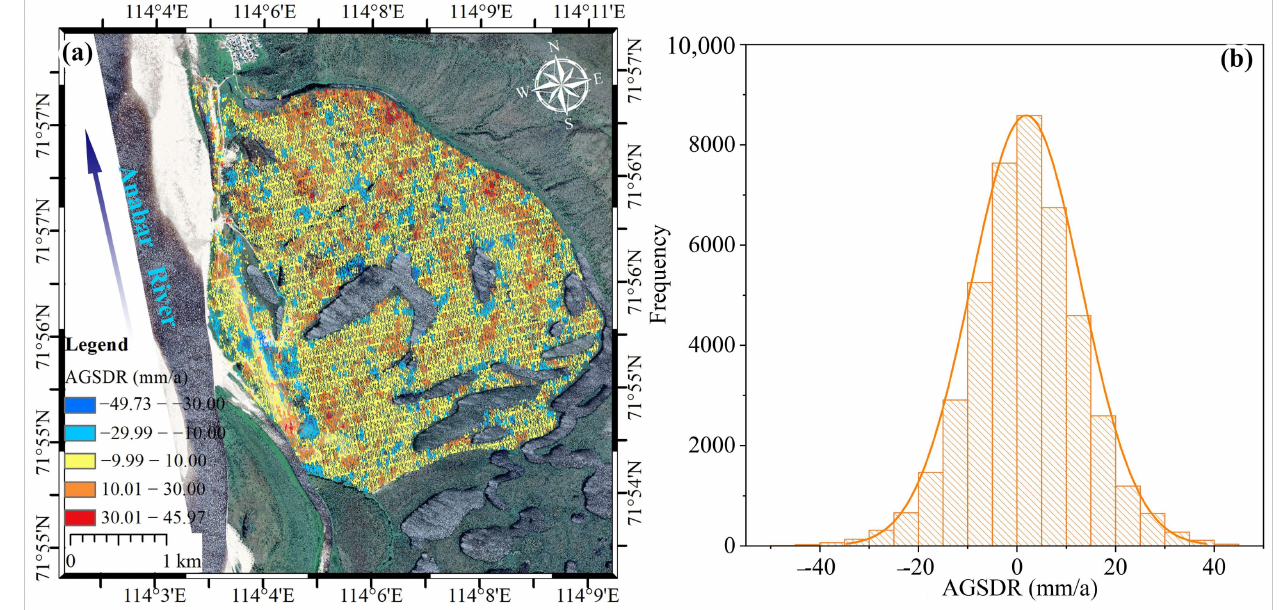
Figure 4. Annual ground surface deformation rate (AGSDR) and histogram of AGSDRs with fre- quency in Saskylakh, northwestern Yakutia, Siberian Arctic, Russia. Notes: ( a ) distribution of AGSDR in Saskylakh; and ( b ) histogram of AGSDR in Saskylakh, or the frequency distribution of percentage for different AGSDR